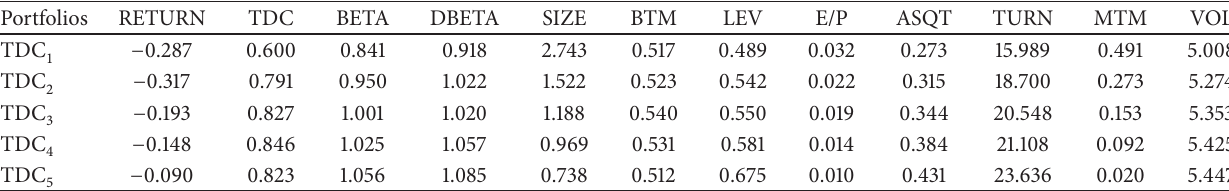
Table 3: Summary statistics for portfolios sorted by preranking TDCs. This table presents the full-period tail dependence coefficients, and the time-series averages of other characteristics for portfolios sorted by preranking tail dependence coefficients (TDCs) monthly. RETURN here is the average of postranking monthly returns. All other variables are defined as in Table 2. The portfolios with subscripts from 1 to 5 contain the stocks ranked by the preranking TDCs from the lowest to the